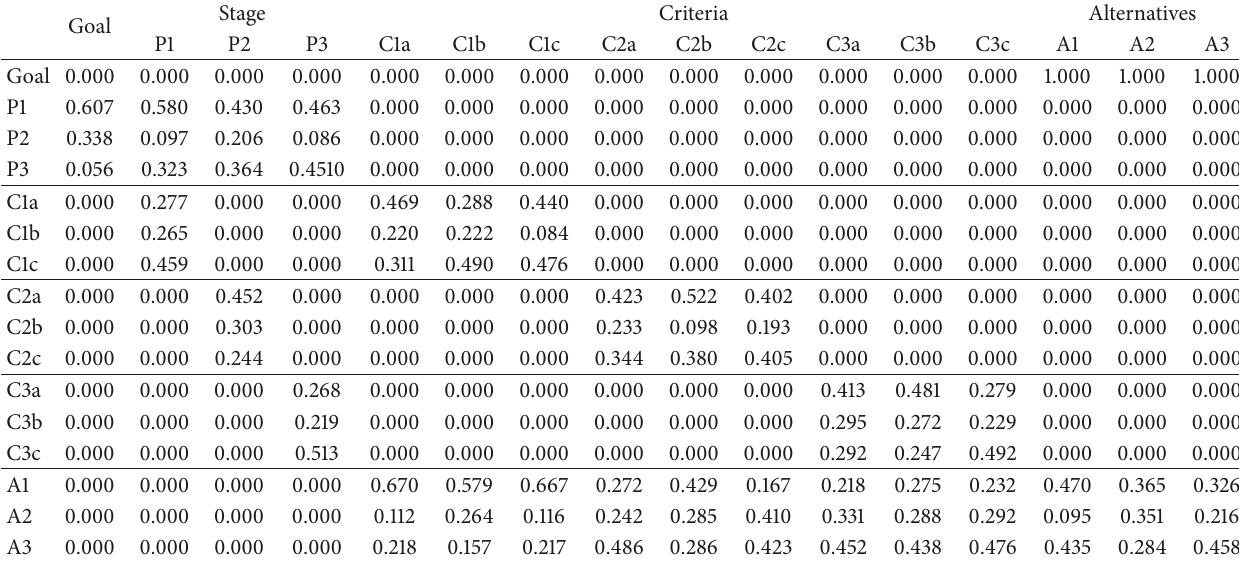
Table 4: Unweighted